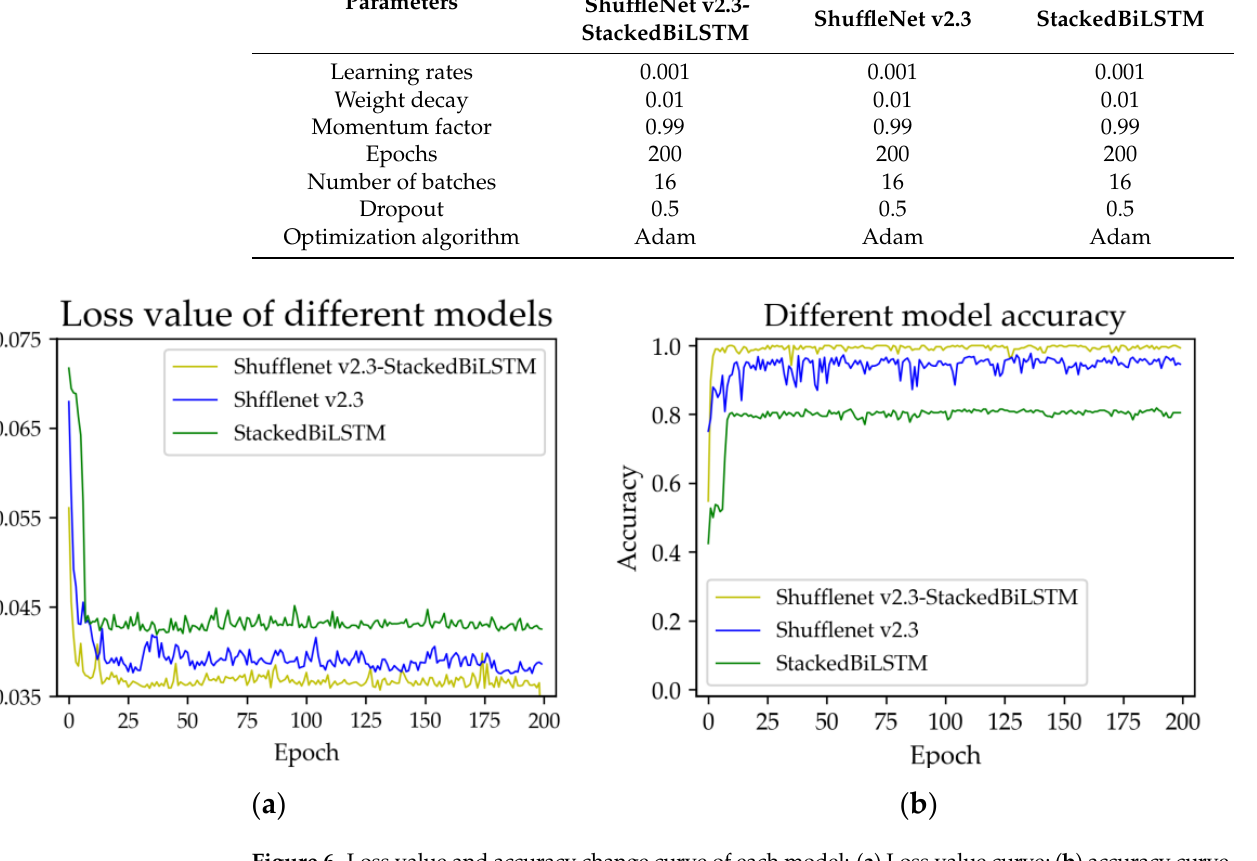
Figure 6. Loss value and accuracy change curve of each model: ( a ) Loss value curve; ( b ) accuracy curve. The total number of test set samples was 158, and the test sets were put into the converged and saved ShuffleNet v2.3-StackedBiLSTM, ShuffleNet v2.3, and StackedBiLSTM models for test evaluation respectively. The results of the test evaluation through the confusion matrix are shown in Figure